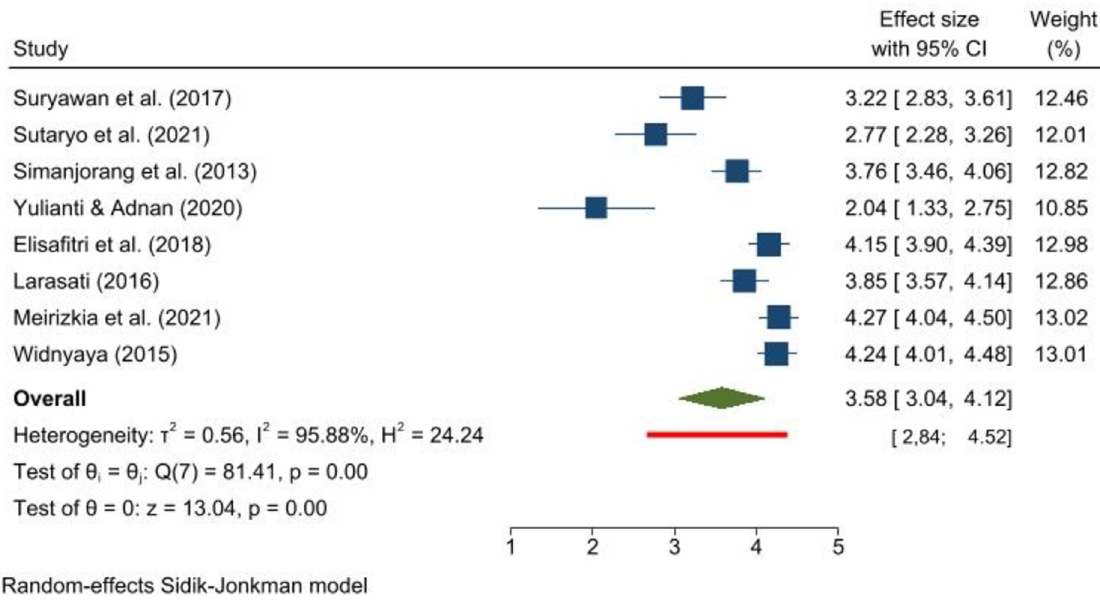
Fig 3. Forest plot showing the case fatality rate and prediction interval of childhood acute lymphoblastic leukemia.